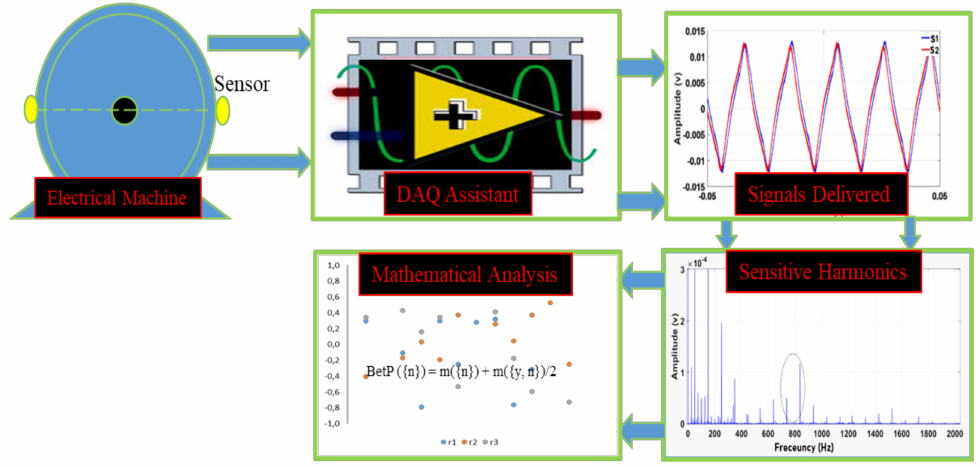
Figure 2. Analysis procedure using the magnetic stray flux.